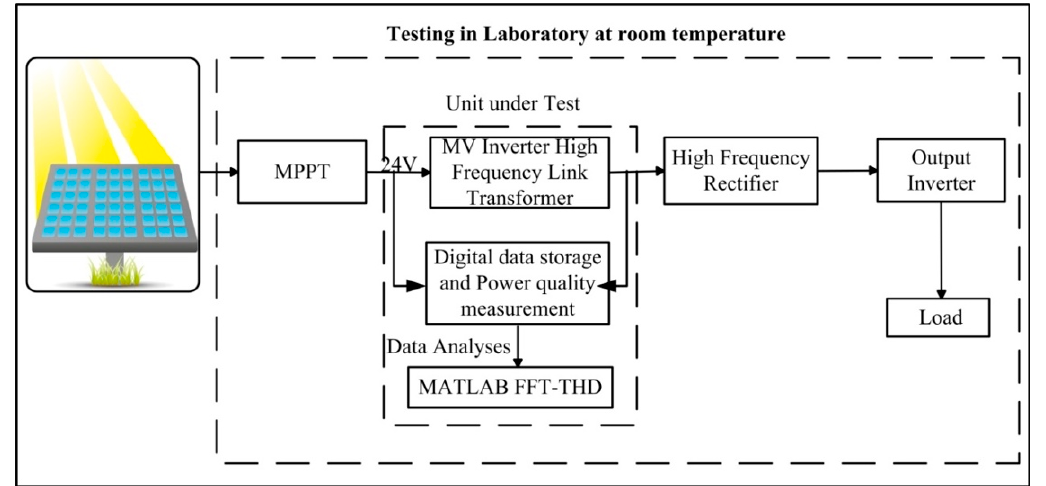
Figure 10. Block diagram for the testing process for prototypes PV high frequency based MV inverter systems. THD—total harmonics distortion.